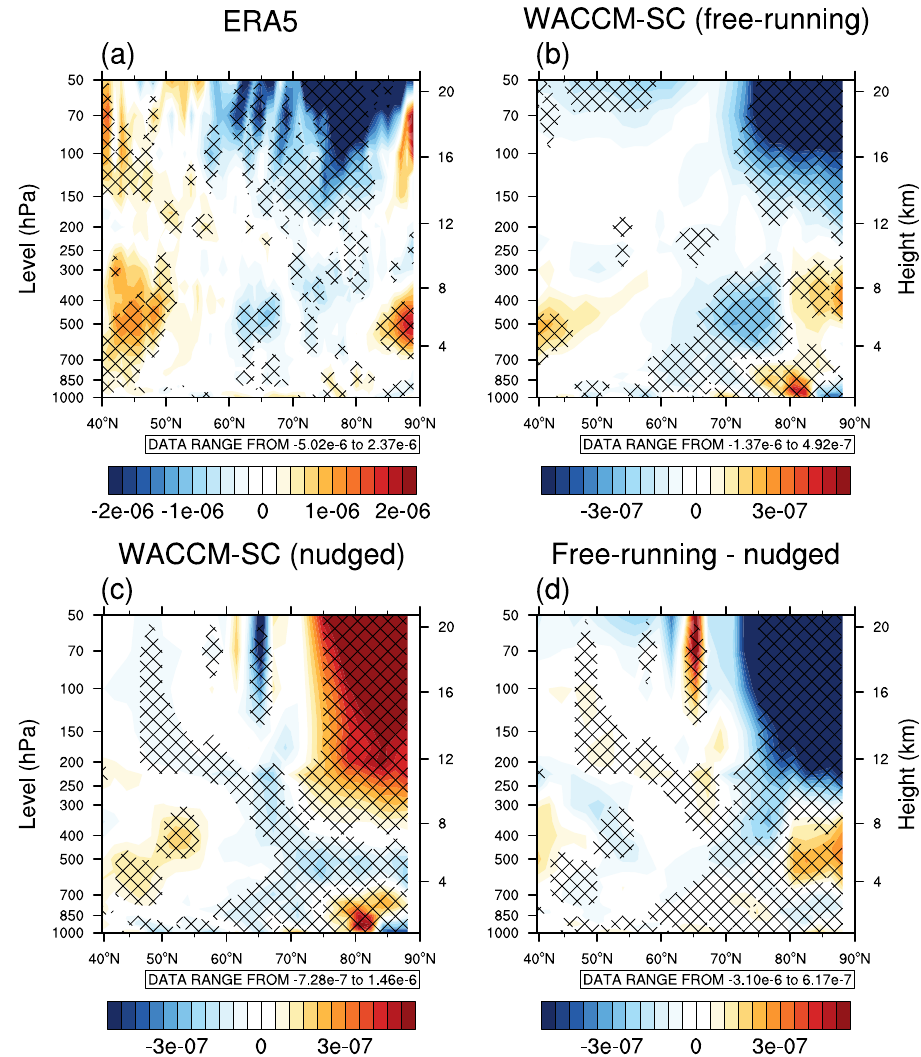
Fig. 4 Winter residual vertical velocity anomalies induced by BKS sea-ice loss. a Winter-mean residual vertical velocity (m s − 1 ; scaled by air pressure) regressed against BKS sea ice, multiplied by the composited SIC differences between BKS low- and high-SIC years, derived from the ERA5 reanalysis. Simulated differences of zonal-mean winter residual vertical velocity between LICE and HICE runs in the b free-running WACCM-SC simulations, c nudged WACCM-SC simulations, and d their differences (free-running minus nudged). The information of data range is placed above label bar. Hatched regions are statistically signi fi cant at the 90% con fi dence level according to bootstrap resampling statistical